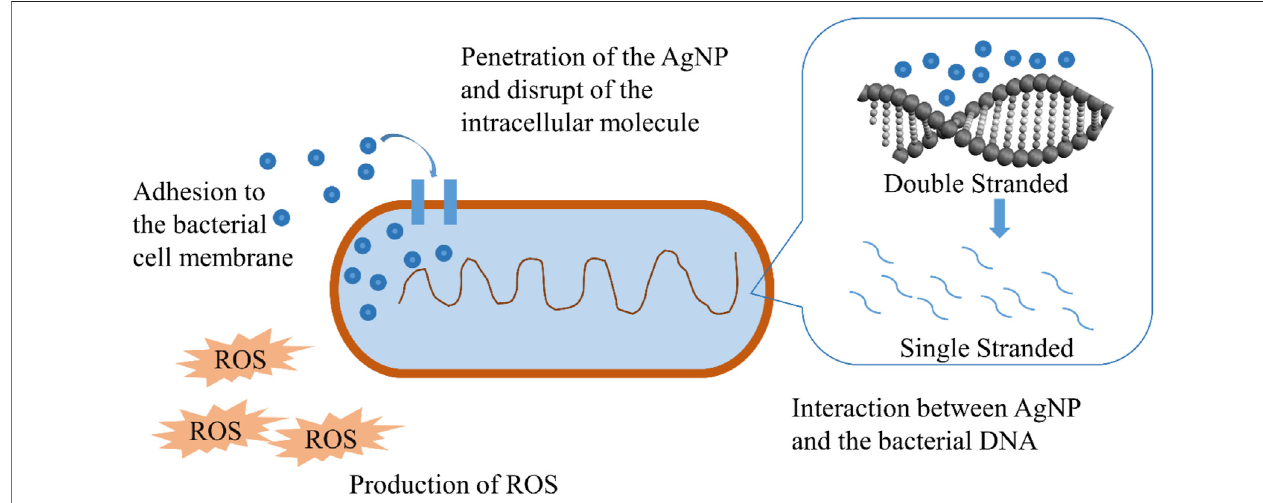
FIGURE 2 | Antibacterial action of silver nanoparticles via ROS